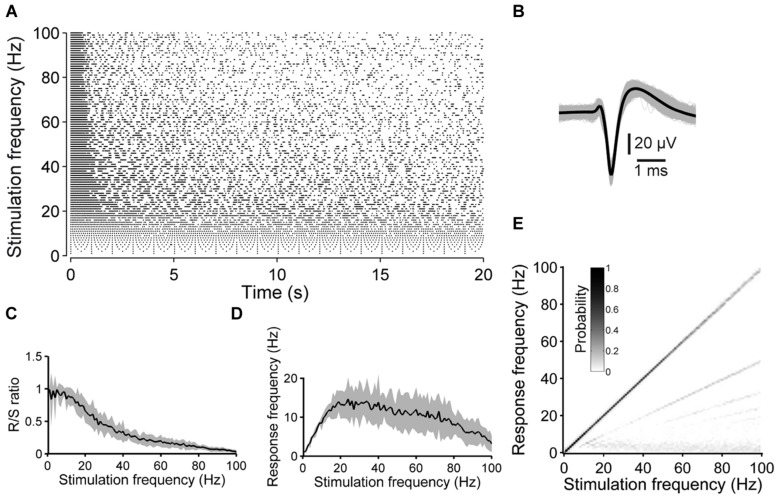
Synaptically independent spike responses to 1–100 Hz stimulation. (A) The raster plot shows an example of the spike responses to 20 s long pulse trains applied at various stimulation frequencies. (B) All ≈20000 spike waveforms detected during the experiment in (A) (gray: single spike, black: average). (C) R/S ratios and (D) mean spike frequency during the 20 s long stimulation periods as a function of the stimulation frequency, averaged over five experiments with four cultures (shaded areas indicate SEM). (E) The graph shows an estimation of the evoked frequency spectrum below 100 Hz of all stimulation blocks of the experiment shown in (A). At high stimulation rates the neuron is not entrained by the stimulation pulses in a 1:1 manner anymore and, consequently, the main diagonal weakens and lines below the main diagonal become evident.